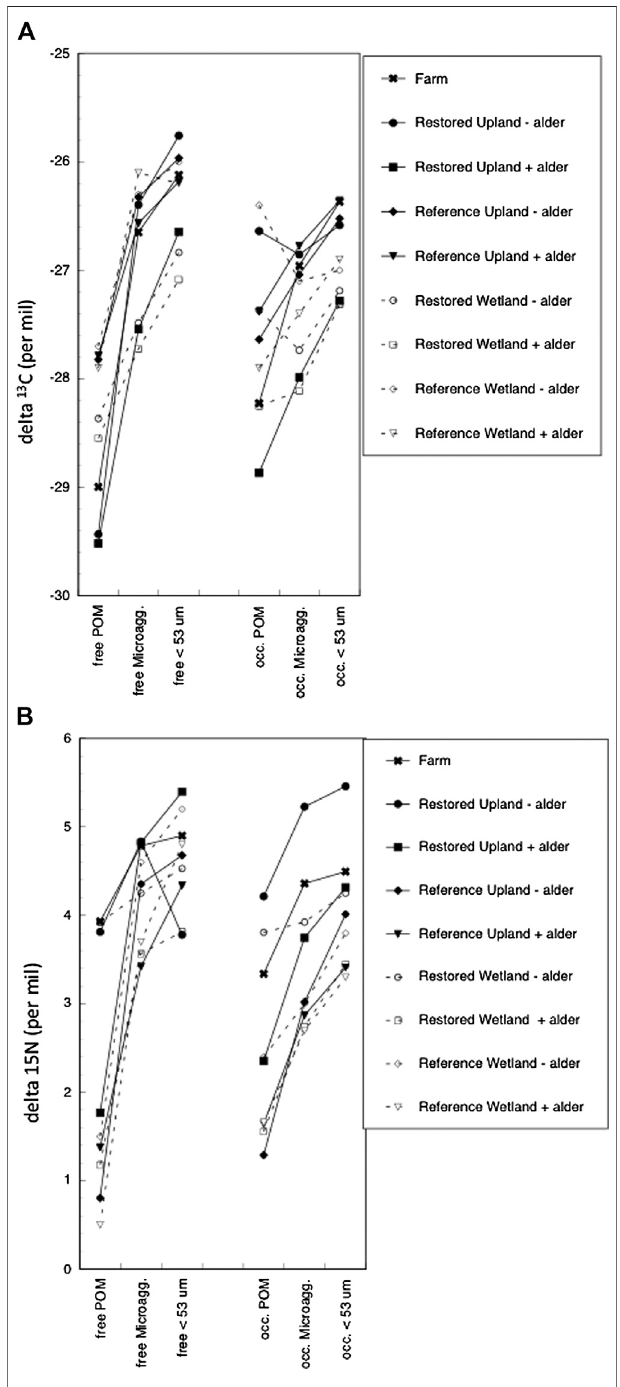
FIGURE 2 | Natural-abundance of stable isotope ratios for carbon (A) and nitrogen (B) in aggregates of bulk soils from nine sites.